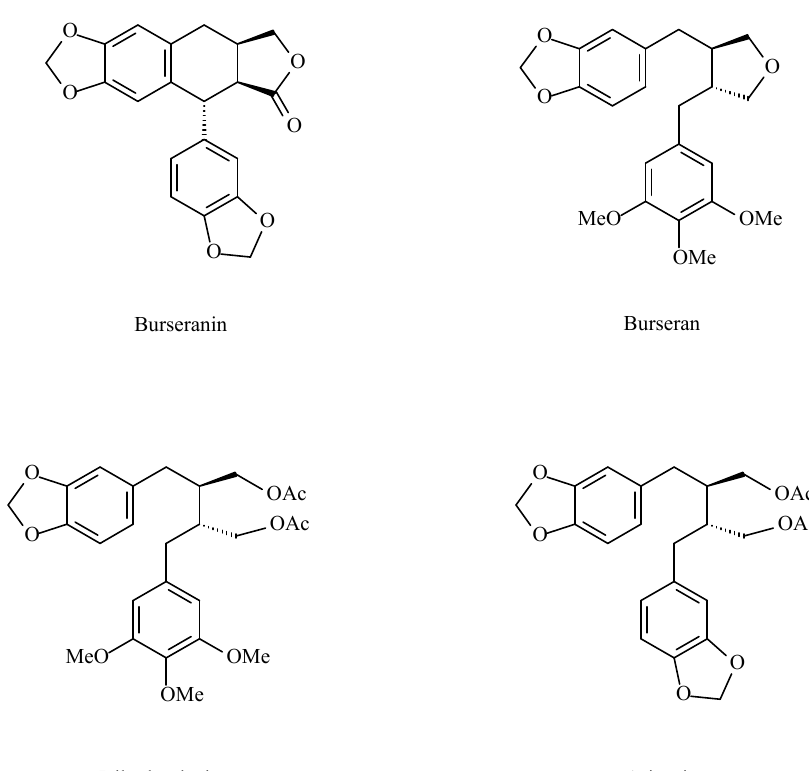
Figure 7. Lignans isolated from B. microphylla resin [31].